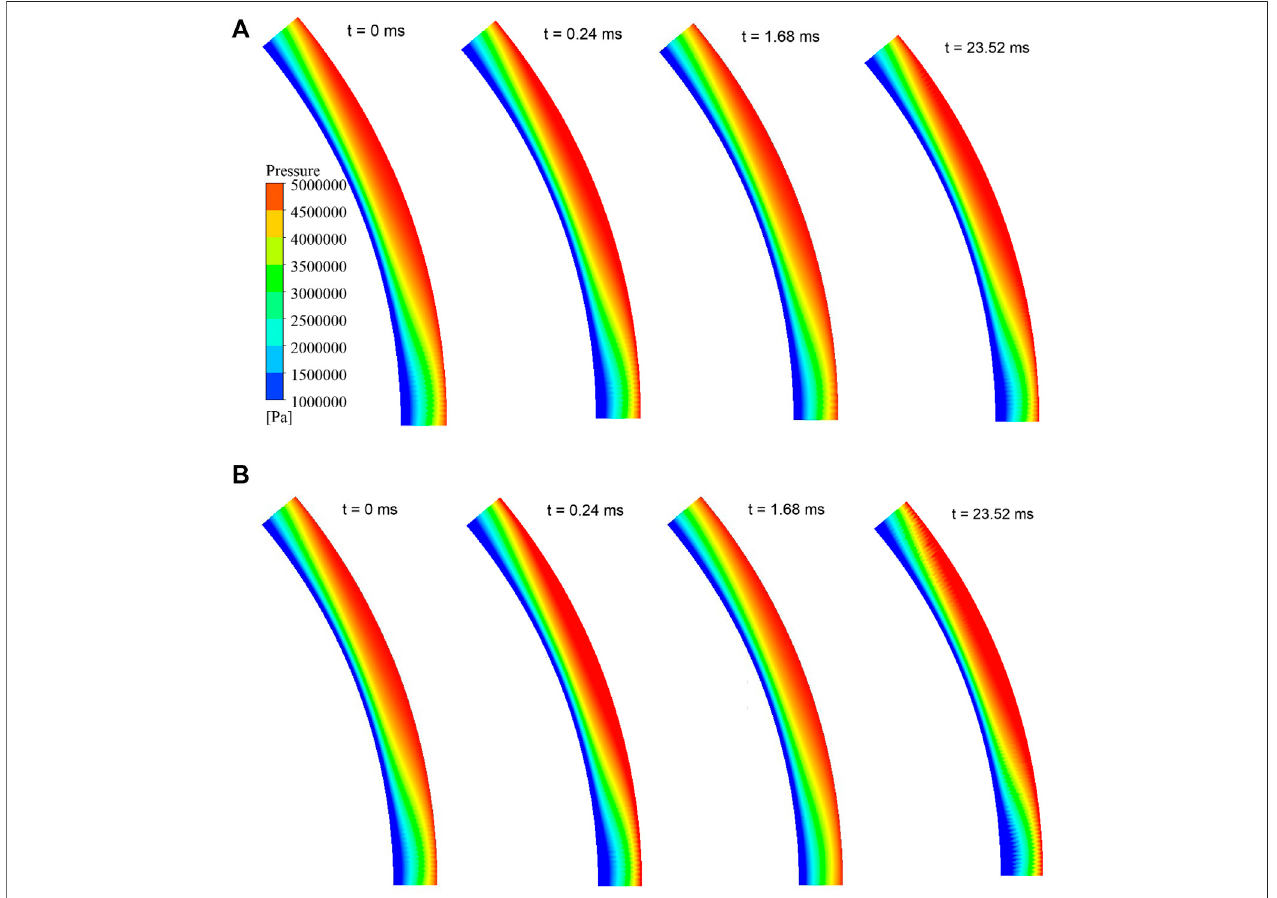
FIGURE 6 | Pressure distribution varies with time (A) a = 4% and (B) a =